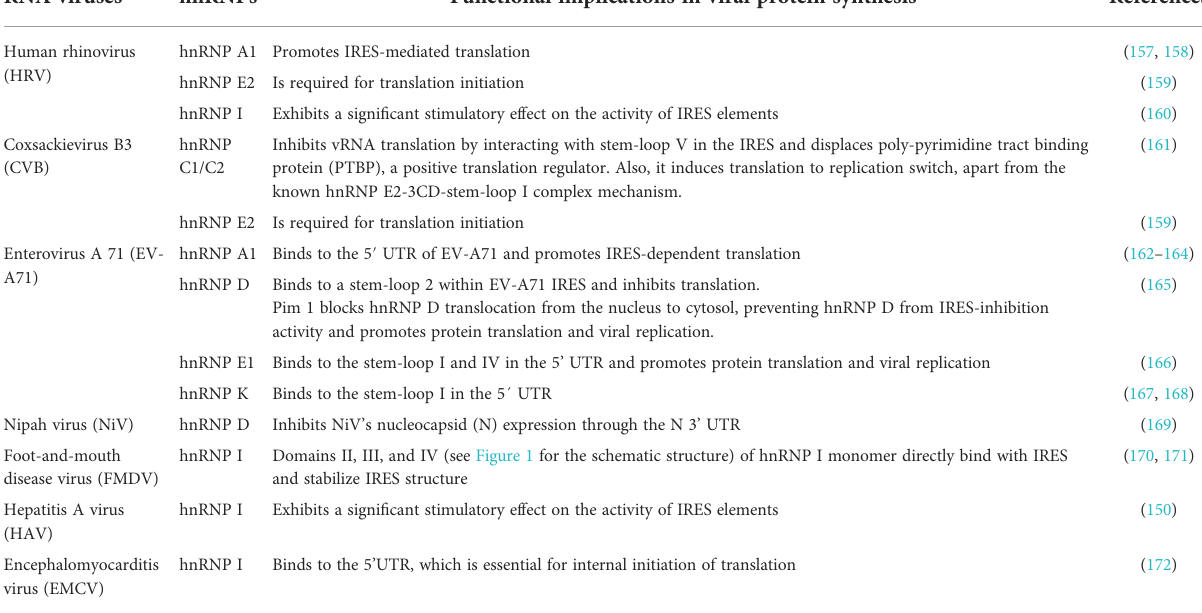
TABLE 4 hnRNPs involved in viral protein synthesis of different RNA viruses. RNA